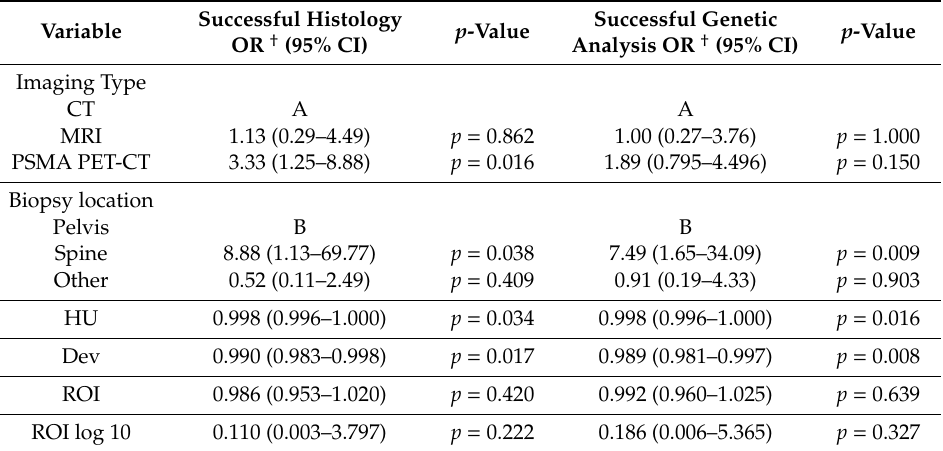
Table 3. Univariate logistic regression.